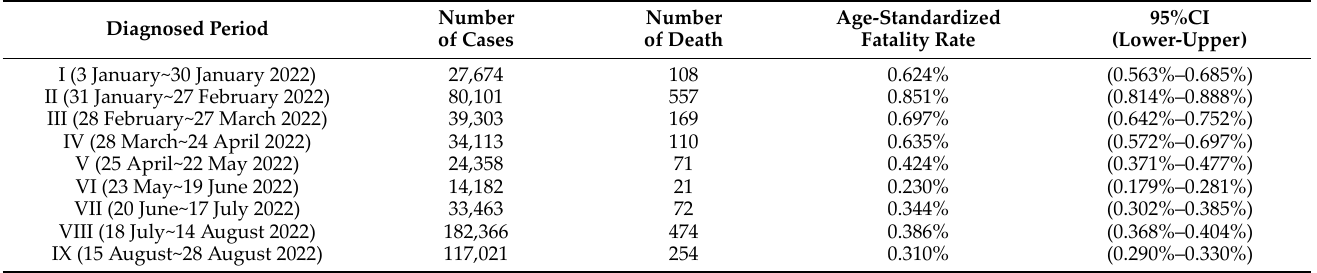
Table A2. Proportion of deaths with COVID-19 among deceased individuals aged ≥ 40 years who were diagnosed with COVID-19 between 3 January and 28 August 2022, in Japan.